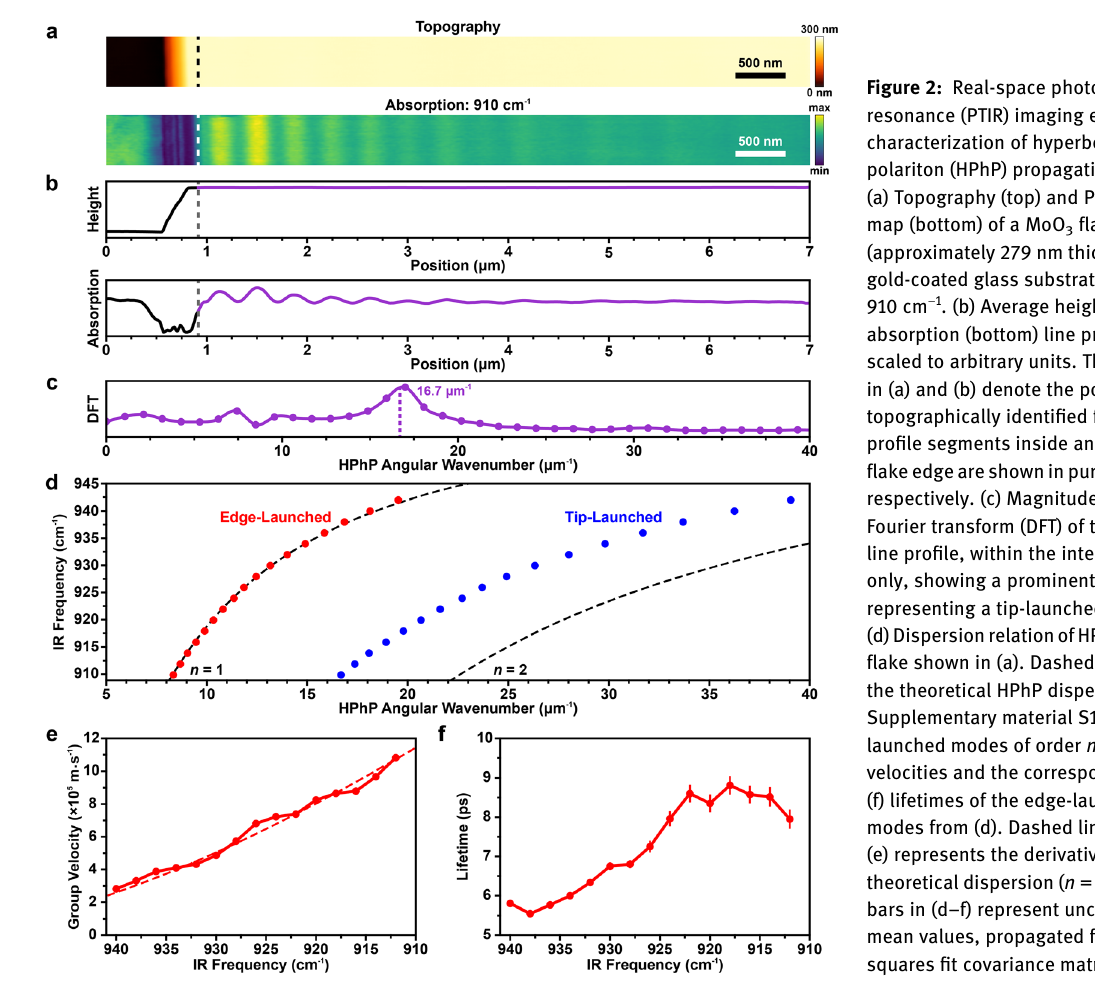
measured intensities. Since, in general, PTIR absorption pro fi les represent superpositions of HPhPs, the model sums over i independent modes, which are identi fi ed by peaks ( k ) in their power spectra (see below and Figure 2c). By fi tting